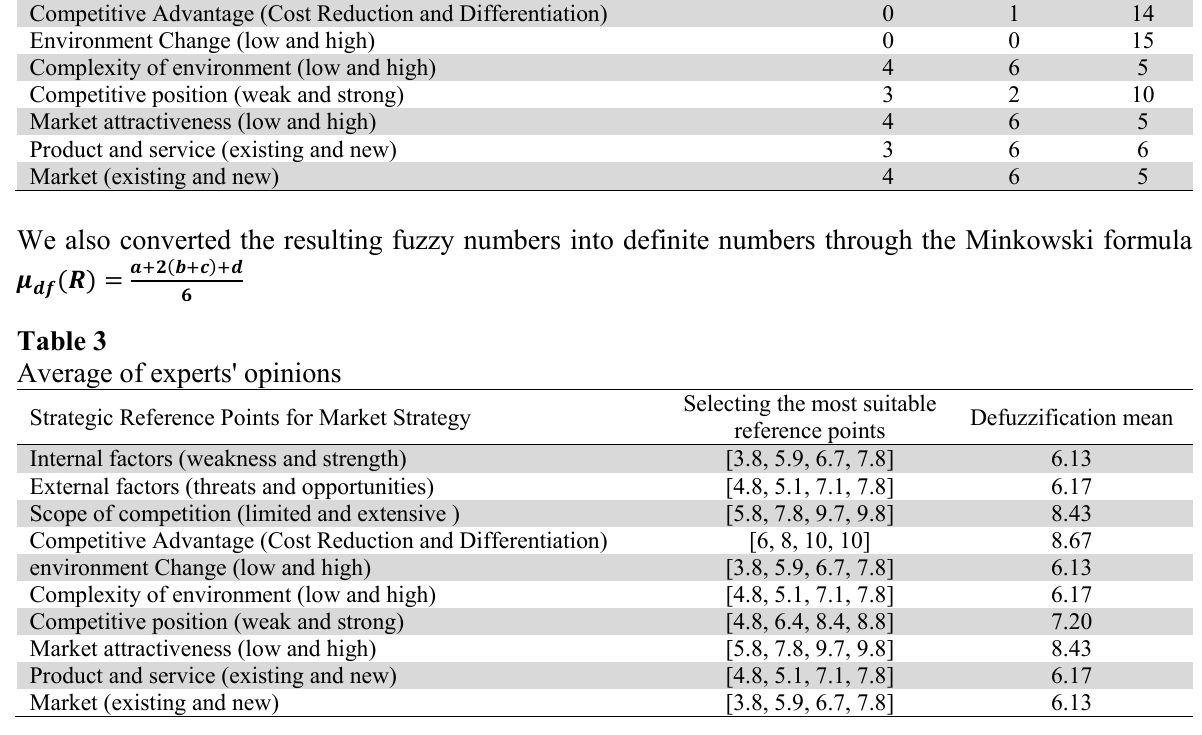
Results from counting the answers of the first questionnaire Strategic Reference Points for Market Strategy Suitability for university Internal factors (weakness and strength) External factors (threats and opportunities) Scope of competition (limited and extensive ) Competitive Advantage (Cost Reduction and Differentiation) Environment Change (low and high)